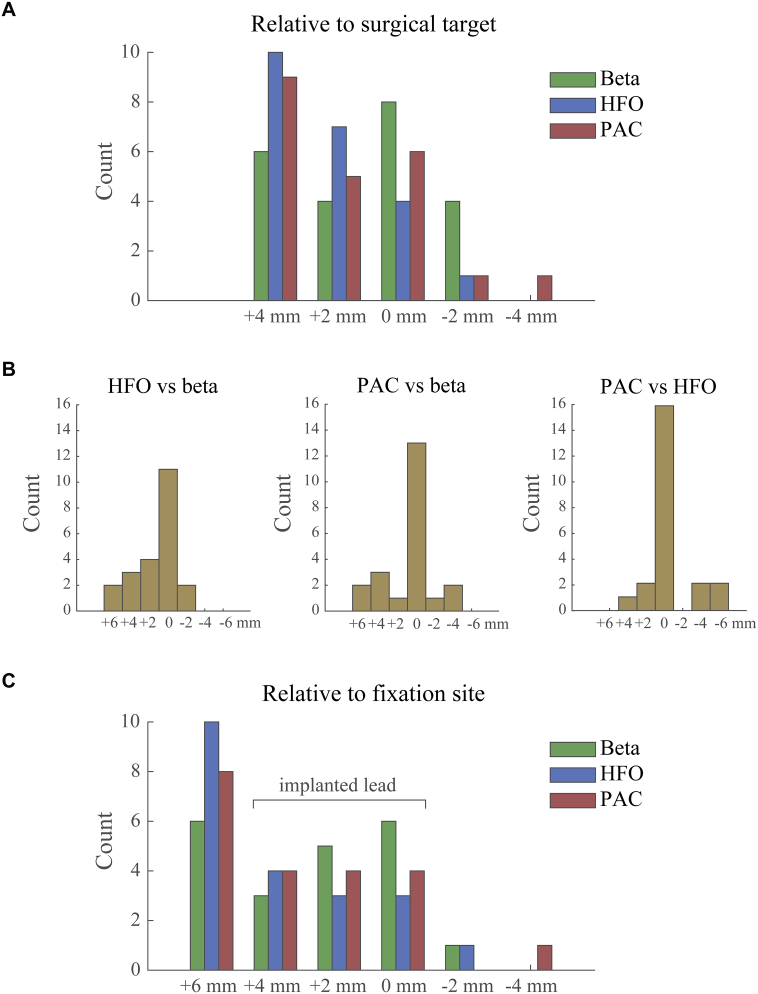
Spatial distribution of largest beta/HFO power and PAC across recording sites. All plots show histograms with the number of observations. Panel A depicts the distribution of recording sites relative to the surgical target point. The relative locations of largest power and PAC within nuclei are shown in panel B. Although largest beta and HFO power occurred at the same recording site in half of the nuclei, HFO tended to peak at slightly more superior sites for the other nuclei. Panel C depicts the distribution of recording sites relative to the fixation site of contact C0. The range spanned by the implanted lead is indicated in the Figure. This reveals that several sites with largest power or PAC are not covered by the lead after implantation. In all cases, positive distances indicate more superior locations. For nuclei with 5 recording sites available the relative distance between sites with maximum power or PAC did not exceed 6 mm. The nucleus where contact C0 was fixated at − 1 mm was discarded from the relative to fixation site histogram.